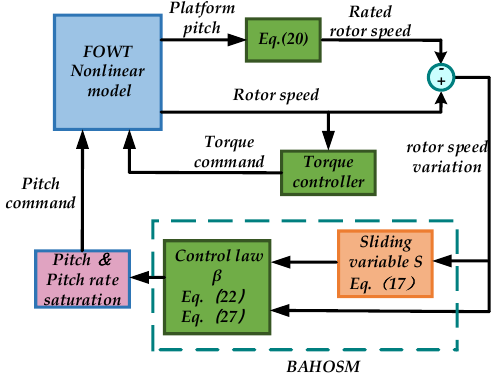
Figure 1. The proposed BAHSOM control scheme.